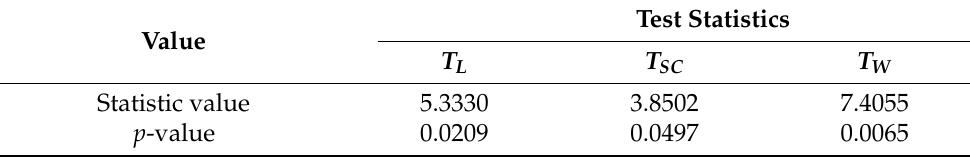
Table 9. Statistic values and p